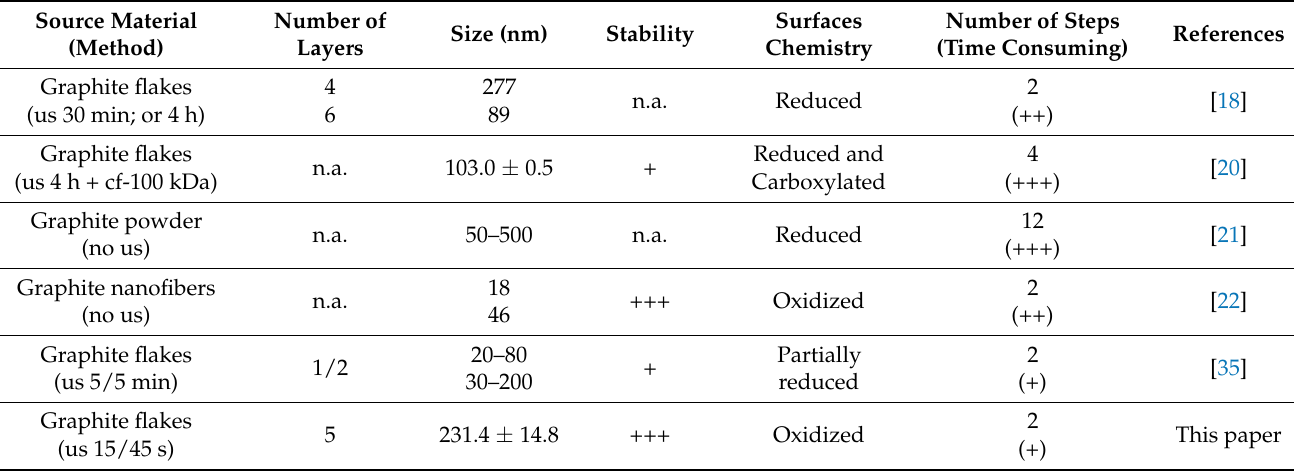
Table 1. Summary of n-GO synthesis methods proposed in the literature indicating the differences in selected nano-sized graphene oxide